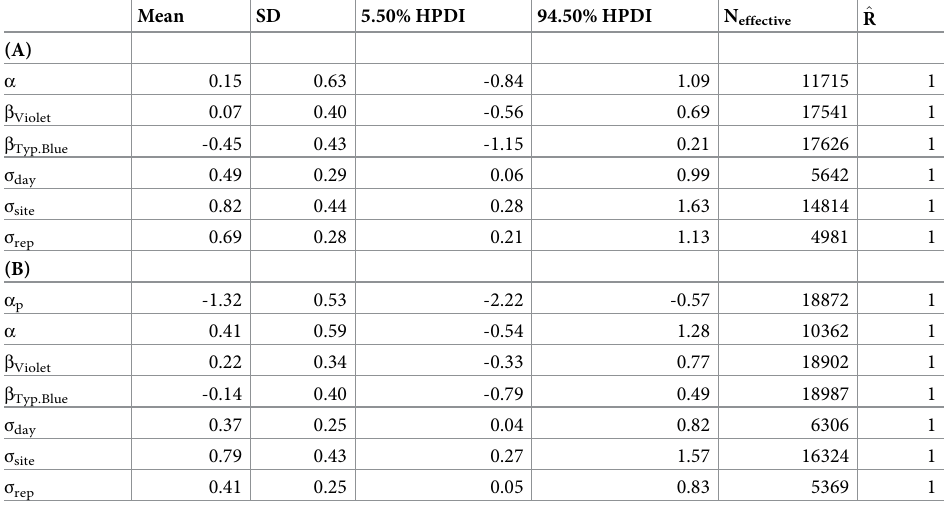
Table 5. A summary of posterior distributions for the coefficients estimated by analysis of experiment 3 data using (A) over-dispersed Poisson, and (B) zero-inflated over-dispersed Poisson models. Mean SD 5.50% HPDI 94.50% HPDI